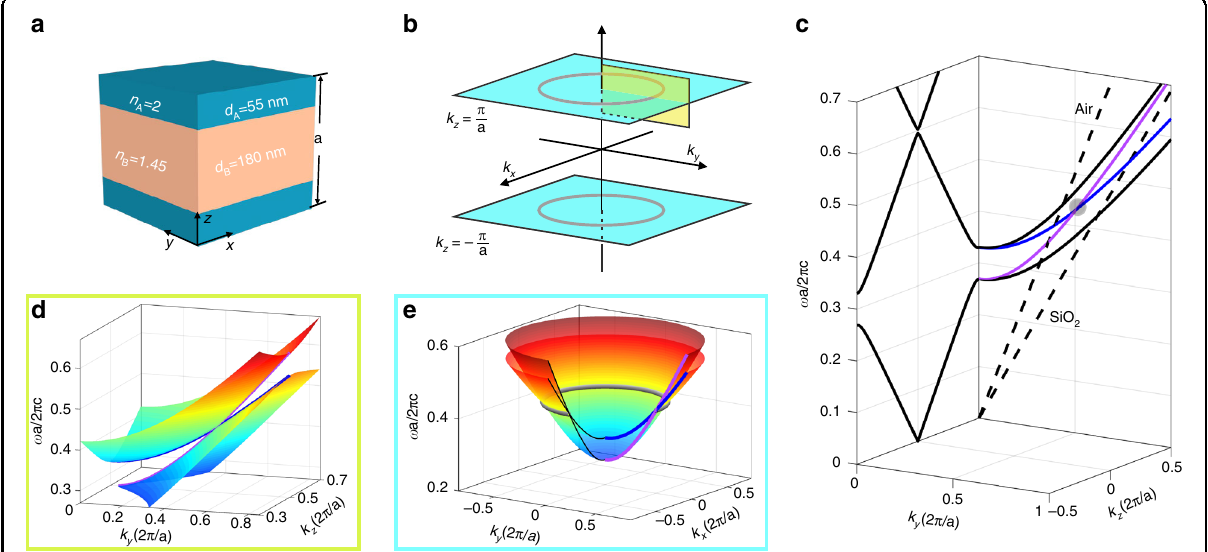
Fig. 2 One-dimensional (1D) photonic crystal with ideal type-II nodal ring. a Unit cell of the 1D nodal ring photonic crystal (NRPC). It consists of three dielectric layers (A/B/A) and obeys inversion symmetry. The refractive index and thickness of layer A (B) is 2 (1.45) and 55 nm (180nm), respectively. b 3D Brillouin zone of the 1D crystal. The two cyan planes highlight the Brillouin zone boundaries at k z = ± π / a , on which the gray circles mark the nodal ring. c Band structures along k z and k y directions. The dashed lines represent the light lines of air and SiO 2 . d Zoom-in view of the tilted Dirac cone on the k y – k z plane highlighted by yellow in b . e Band dispersion on the k x – k y plane with k z = π /a, which has a type-II nodal ring crossing (gray torus). For a better view of the nodal ring, only three quarters of the bands are